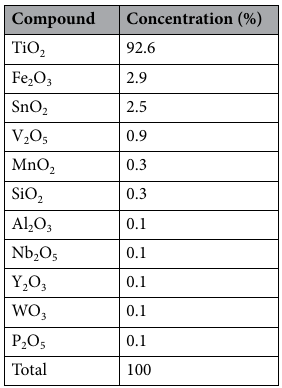
Table 8. Result of XRF analysis of the leaching